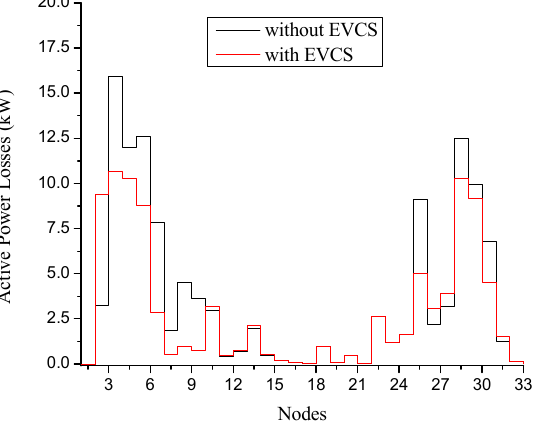
Figure 8. Active power losses with and without the integration of EVCS. EVCS was integrated at node 9 using a genetic algorithm with a capacity of 663.9 kVA and reactive power losses of 104.98 kVAr. Figure 9 shows the graphical comparison between reactive power losses with and without the integration of EVCS.